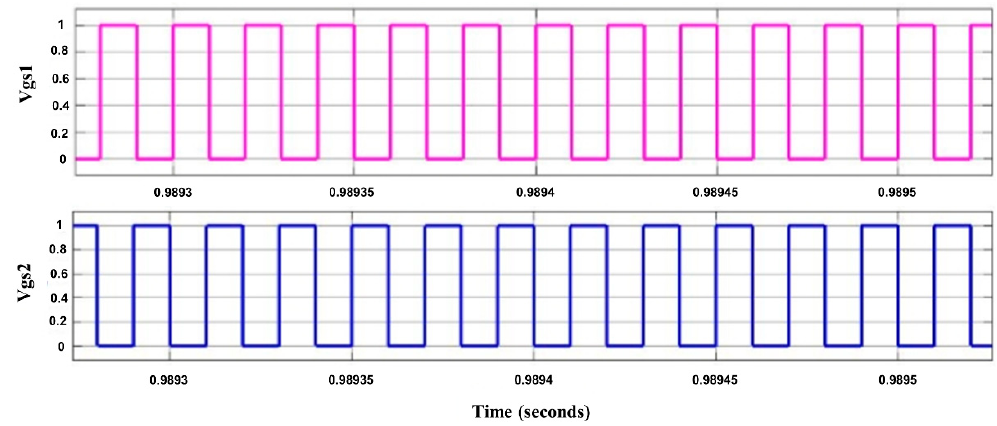
Figure 12. Power and voltage waveforms (input and output) for ferrous heating mode during simulation.